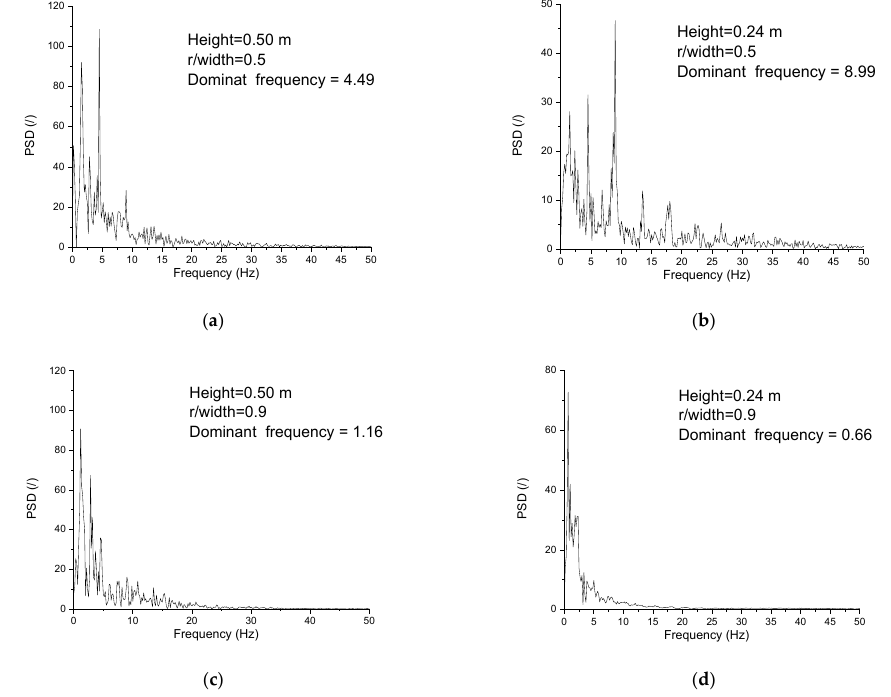
Figure 14. Power spectral density as a function of porosity of particles used in experiment at the height of 0.24 m and 0.5 m, r/Width = 0.5 and 0.9, ρ p = 2700 kg/m 3 . ( a ) central distribution, 0.5 m; ( b ) central distribution, 0.24 m; ( c ) wall distribution, 0.5 m; ( d ) wall distribution, 0.24 m. Fig ure 15 denotes the comparisons of porosities particles with density of ρ p = 2700 kg/m 3 and ρ p = 800 kg/m 3 at the height of 0.24 m and 0.5 m. It is noted that particle inertia has great impact on the particle motions and porosities. Smaller particle porosities are found for heavy particles because larger particle inertia aggregates bubble coalescence and breaking-up and particle falling and particle circulations around smaller size bubbles, which intensifies the interactions between and particle and particle–particle collisions.